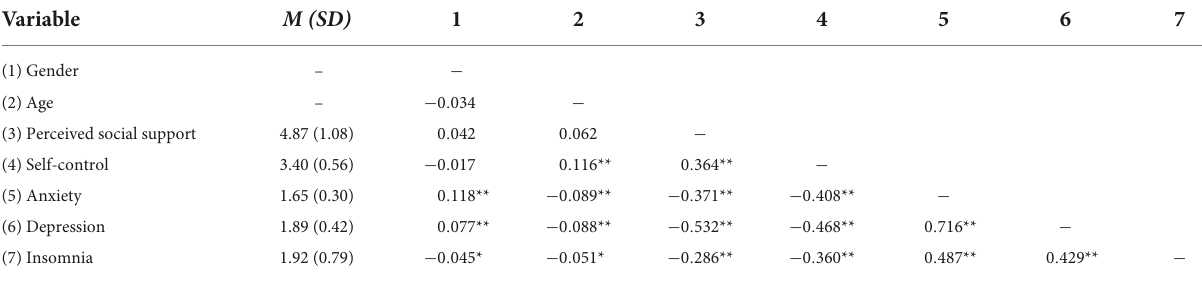
TABLE 1 Descriptive statistics and correlations of perceived social support, anxiety, depression, and insomnia ( N = 1,997).